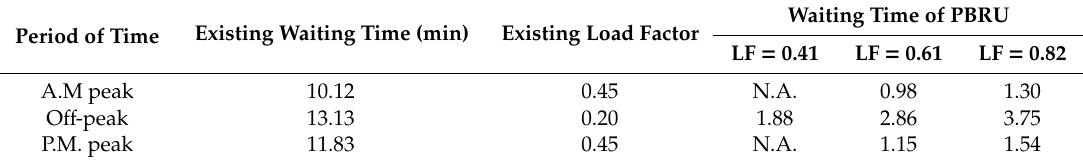
Table 4. Waiting Time (min) before and after the Bus Reform for each Load Factor.